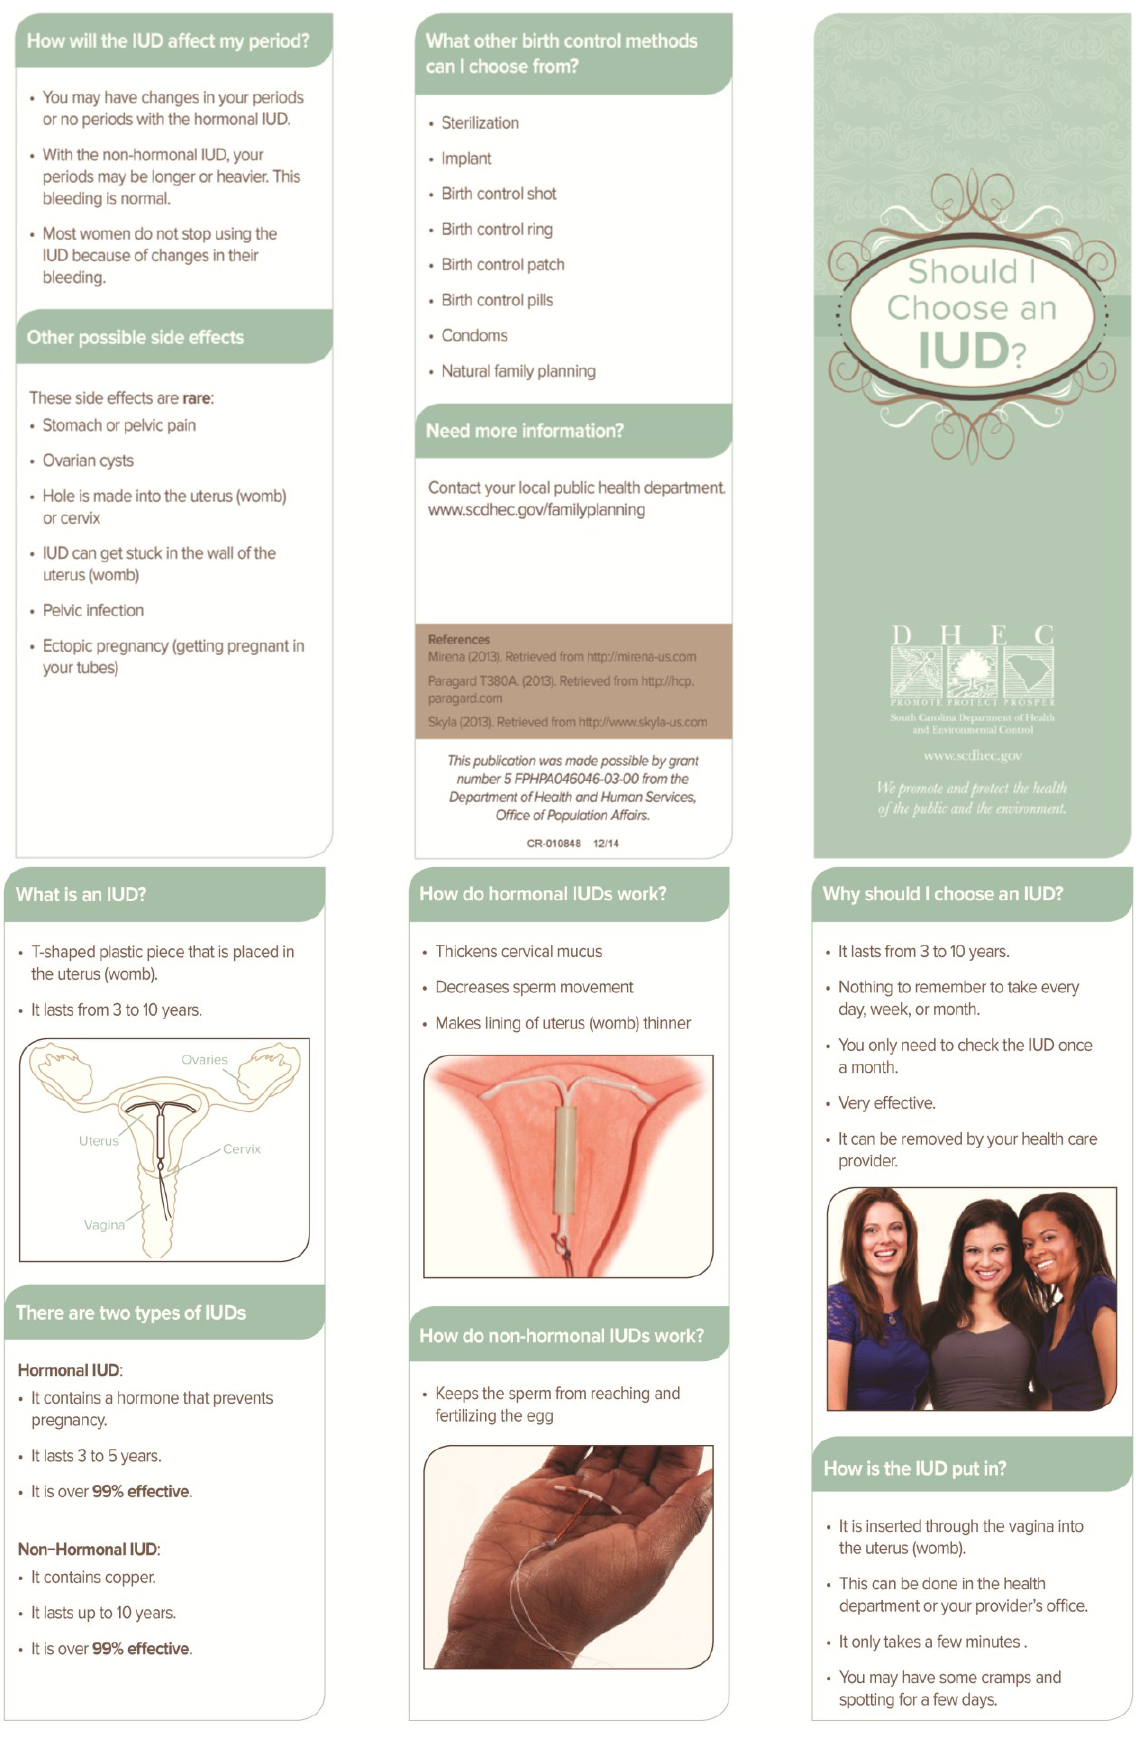
Figure 2. Shared Decision Aid, English Language: “Should I Choose an IUD?”